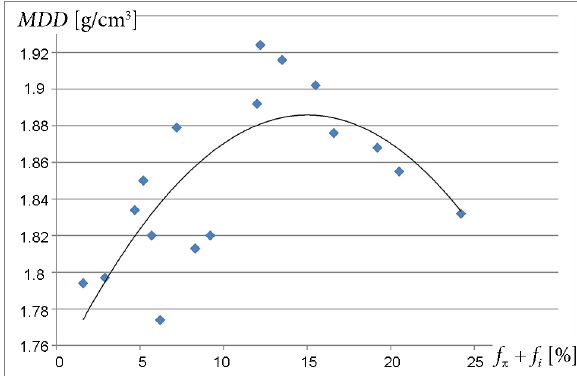
Figure 5. The dependence between the maximum dry density and the content of fine fractions